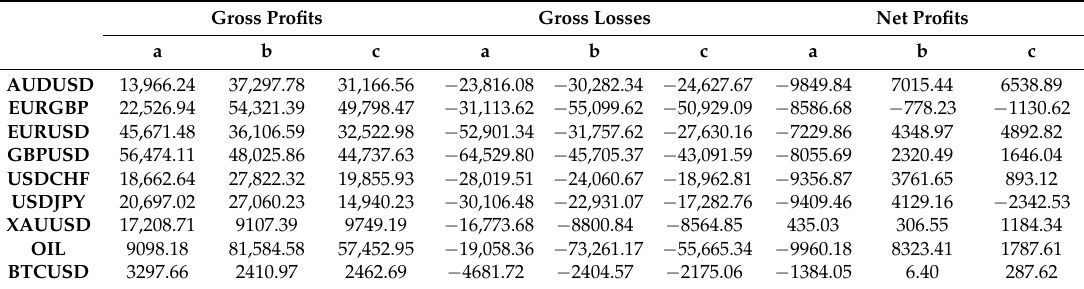
Table A1. Results of experiments (a), (b), and (c).